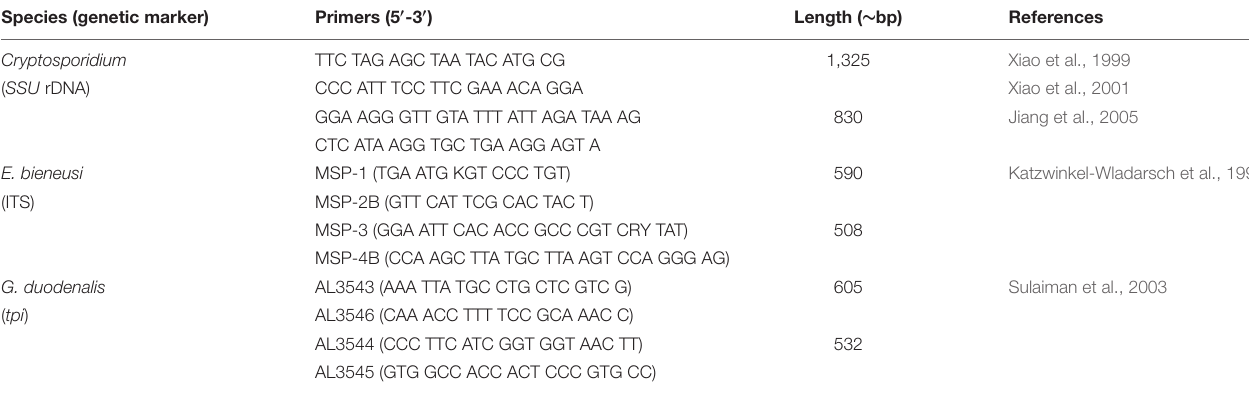
TABLE 1 | PCR primers (forward and reserve) used for the amplification of Cryptosporidium , Enterocytozoon bieneusi , and Giardia duodenalis in this study. Species (genetic marker) Primers (5 (cid:48) -3 (cid:48) )